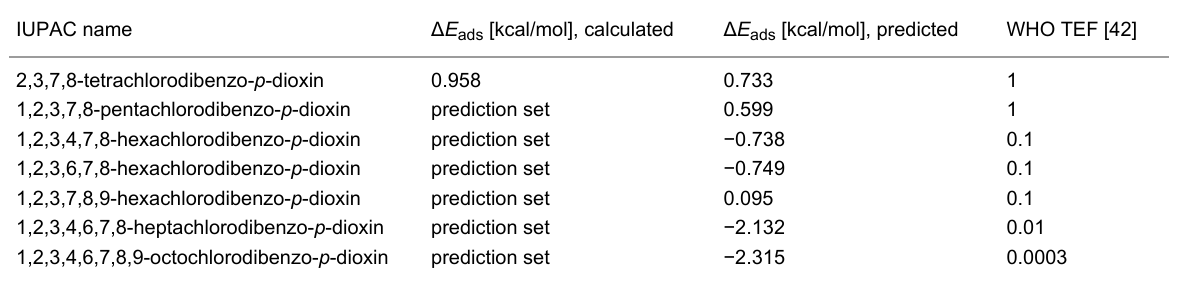
Table 1: Predicted adsorption energies for dioxin congeners compared with official WHO TEF